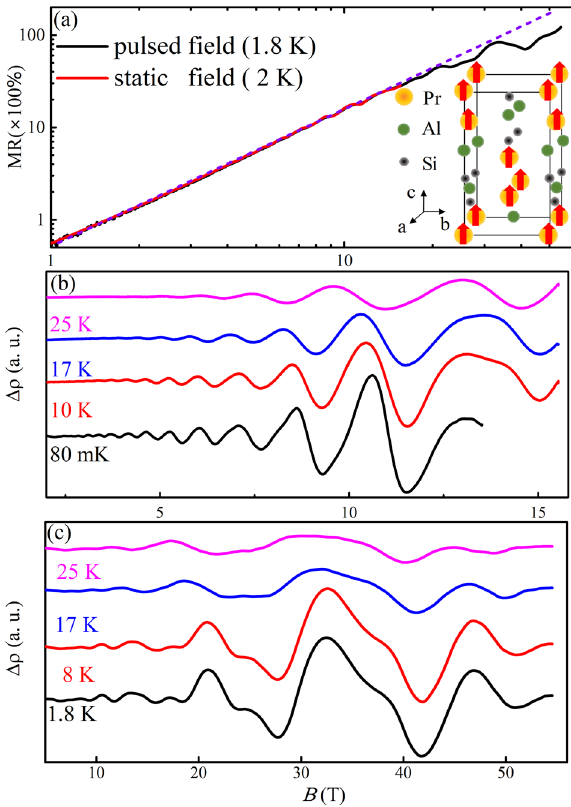
Fig. 1 Quantum oscillations in the magnetoresistance of PrAlSi. a The fi eld-dependent of MR measured under a static fi eld at 2 K and a pulsed- fi eld at 1.8 K. The inset is the crystal structure(I4 1 /md) of PrAlSi as the magnetic fi eld easily polarizes the moments of Pr along the c -axis. b Field dependence of the oscillatory part of magnetore- sistance Δ ρ ( B ) in low magnetic fi eld measured under static fi eld, showing only a single QO frequency. The experiments were carried out with a Leiden dilution refrigerator (14 T) at 80 mK and with a refrigerator of Oxford Instrument (16 T) at T = 10, 17, and 25 K. c Δ ρ ( B ) in high magnetic fi eld measured by the pulsed magnetic fi eld, showing more QO frequencies with a complex pattern. PrAlSi with the magnetic moments of Pr easily orientated along the c -axis after the application of a small fi eld 24 . In our transport measurements, the magnetic fi eld was along the c -axis and the electrical current was along the b -axis (more details are presented in the “ Methods ” section and Supplemental Material). Figure 1a shows magnetoresistance measured in the static fi eld at 2 K (red curve) and pulsed fi eld at 1.8 K (black curve). Normalized magnetoresistance ( ρ ( B ) − ρ (0))/ ρ (0) reaches 116 at 55 T and remains non-saturating. The purple dashed line corresponds to B 1.7 . Figure 1b presents the oscillatory part of the longitudinal resistivity Δ ρ ( B ), obtained by subtracting a smooth background from the measured ρ ( B ) (see Supplementary Fig. 2 for more raw data). At low temperatures, oscillations are visible above the fi eld as low as 3 T, indicating the good quality of the sample. The rough Dingle mobility of 1/ B c = 0.33 T − 1 is close to the average mobility of 0.26 m 2 /V s yielded from the amplitude of the quadratic low- fi eld magnetoresistance (see the inset of Supplementary Fig. 2a). The single-frequency QO for static fi eld measurements retains until temperature down to 80 mK. A more complex pattern emerges when the larger magnetic fi eld is applied, as seen in Fig. 1c. Figure 2a and b show the results of the fast Fourier transformation (FFT) of the oscillatory part of the magnetoresis- tance Δ ρ as a function of 1/ B . The SdH frequencies extracted from